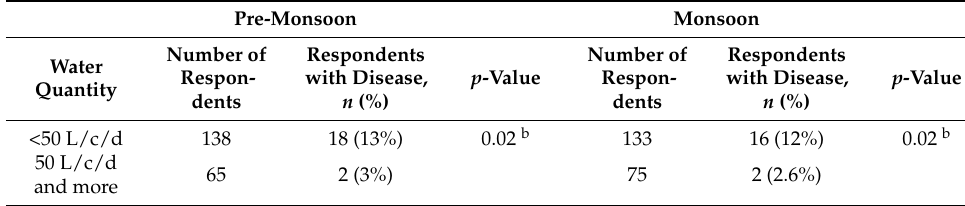
Table 3. Relationship between water consumption and waterborne disease.